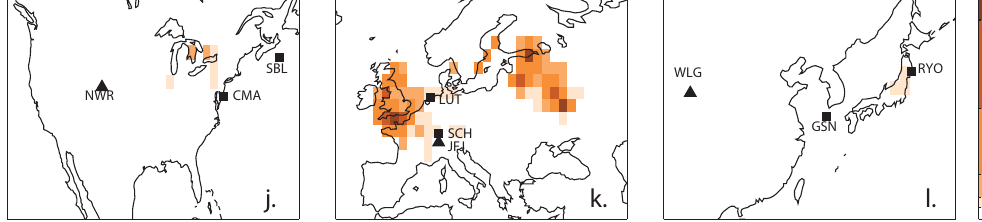
at the lower limit, δ1 nuc and β nuc became 60 % smaller in erage. Potential biases were much less important in North β nuc was still comparable in magnitude to δC ff ( > 20